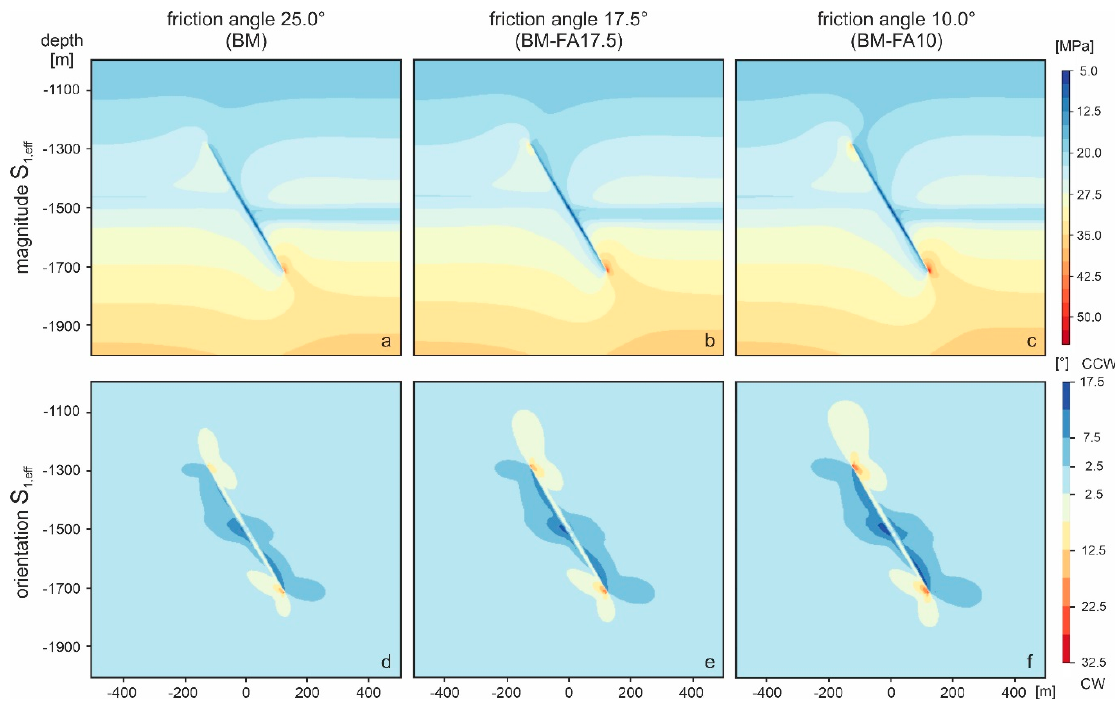
Figure 10. Spatial variation in the magnitude ( a – c ) and the orientation (deviation from vertical; d – f ) of the effective maximum principal stress (S 1,eff ) after five years of injection for three different friction angles assigned to the fault zone.